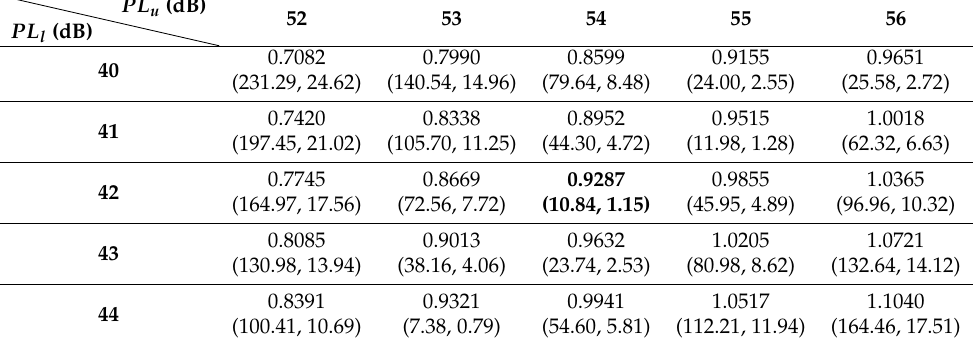
Table 4. Estimation of the step length (m), absolute estimation error (mm), and relative error (%) in the outdoor jogging scenario for different pairs of upper threshold PL u (dB) and lower threshold PL l